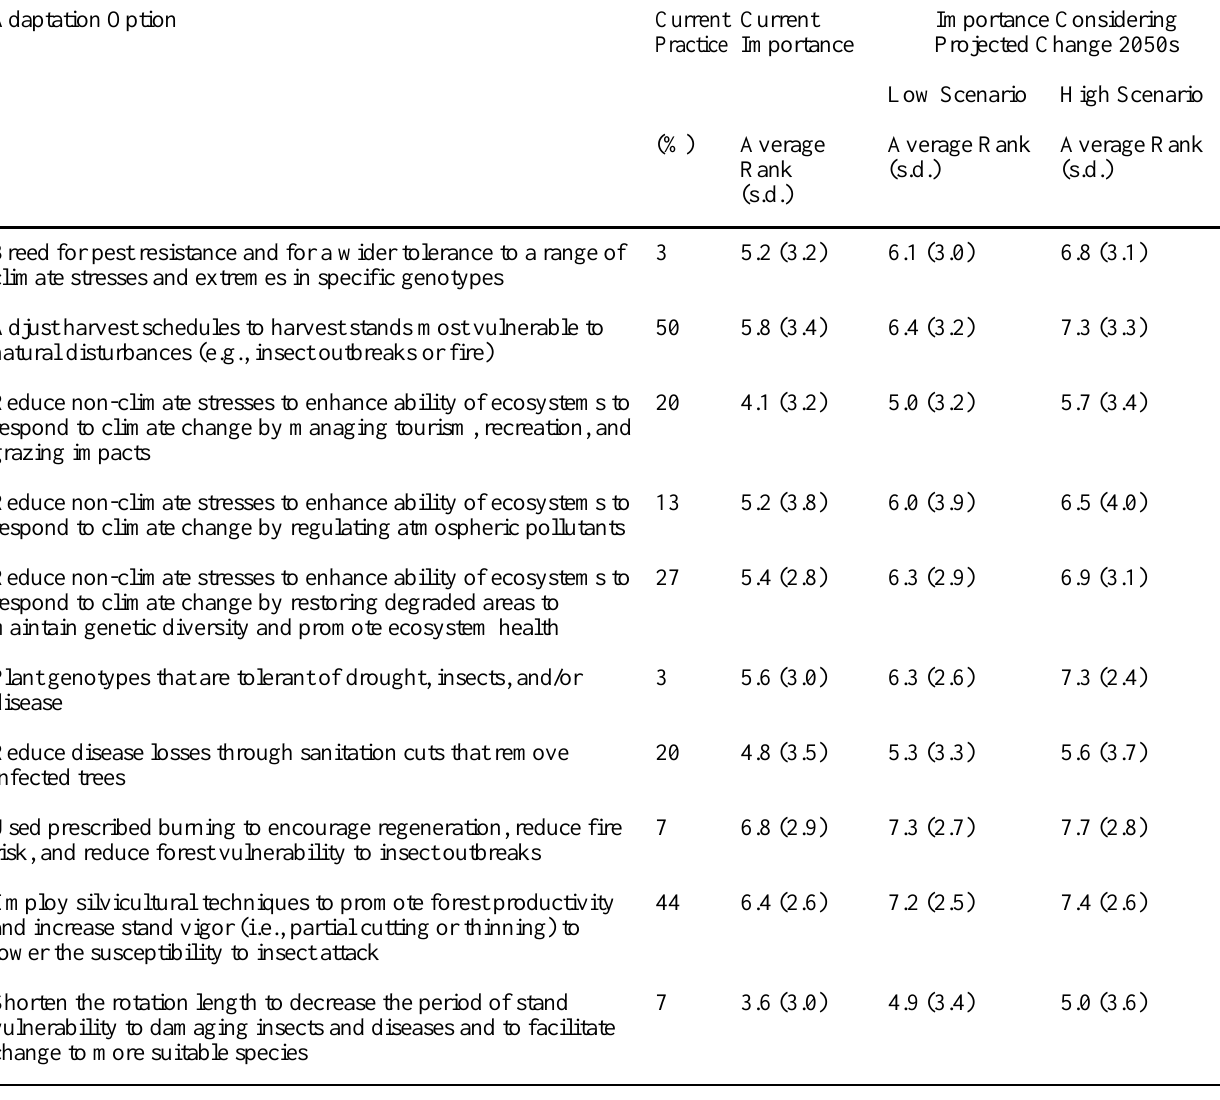
Table 6. Judgments of forest practitioners on the importance of adaptation options to maintain health and vitality of forest ecosystems in the Champagne and Aishihik Traditional Territory for each of three scenarios: “current climate conditions,” “low scenario of future climate change by the 2050s,” and “high scenario of future climate change by the 2050s.” Scale of 1 to 10 (0 = no importance, 1 = low importance, 10 = high importance) or don’t know. Results shown are the average rank and standard deviation (s.d.) of